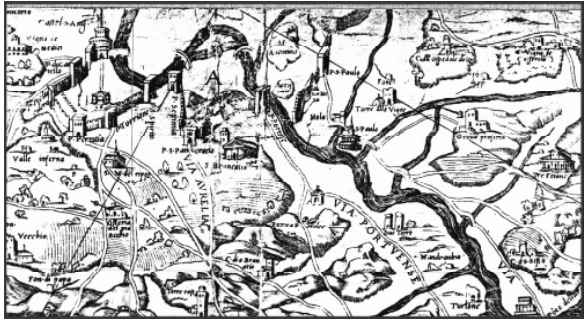
Figure 2. Eufrosino della Volpaia, 1547, detail of sheets 2 e